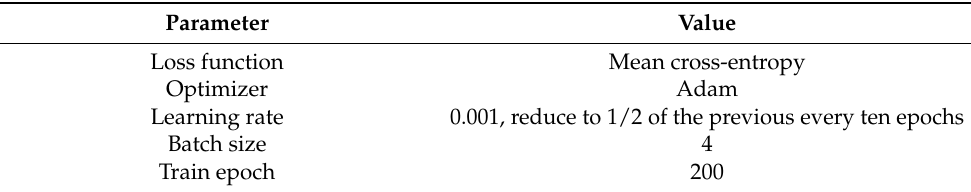
Table 4. Training parameters of